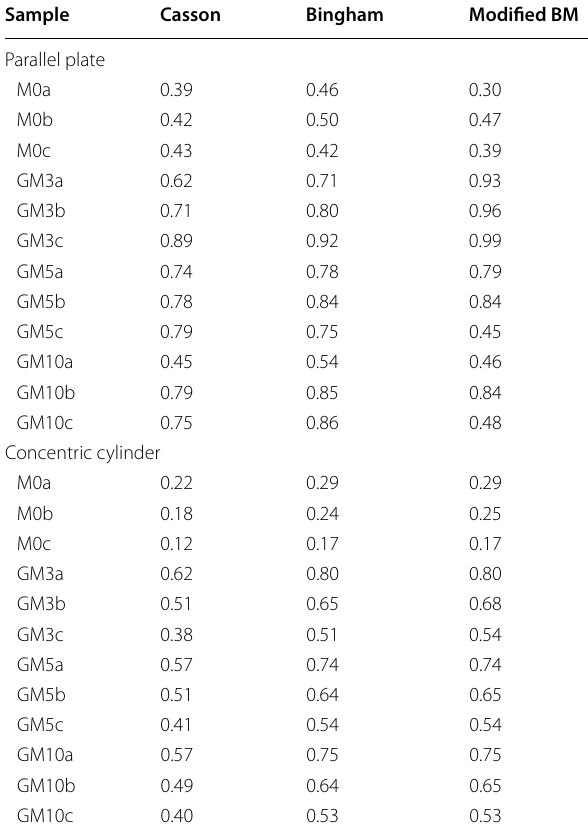
Table 9 Influence of graphene on plastic viscosity values.